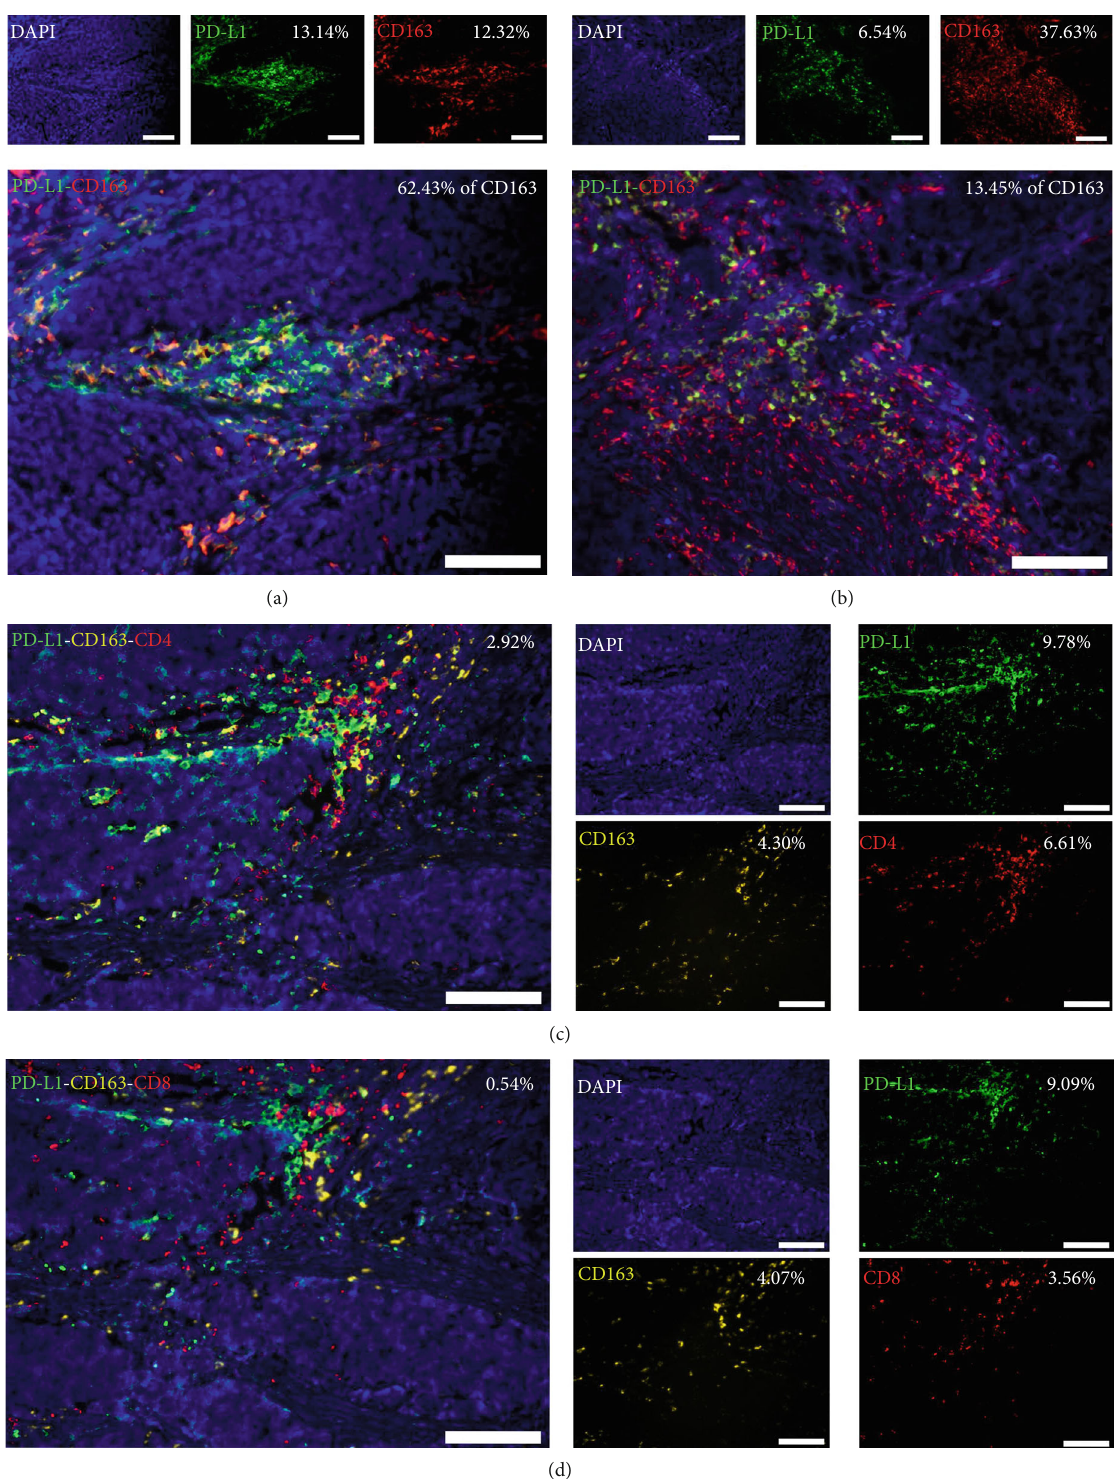
Figure 2: CD4 + TILs colocalize with PD-L1 + CD163 + TAMs. Representative multicolor immuno fl uorescence (multi-IF) images showing (a) high and (b) low colocalization of PD-L1 + cells with CD163 + TAMs. Scale bar, 100 μ m. Representative multi-IF images showing costaining of (c) CD4 + PD-L1 + CD163 + TILs and (d) CD8 + PD-L1 + CD163 + TILs in serial sections of the same specimen. Cells were counterstained with DAPI (blue, nucleus). Scale bar, 100 μ